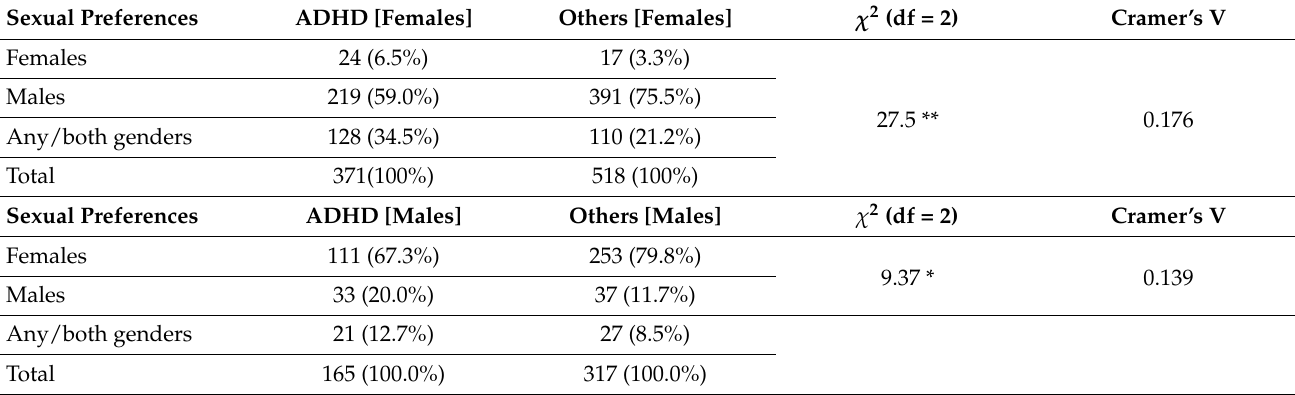
Table 3. Differences in sexual preferences between ADHD and Other participants ( n =